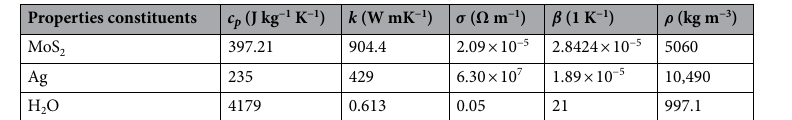
Table 2. Nanoparticles and conventional fluid thermo-physical characteristics (Nazir et al. 50 and Khan et al. 51 ).